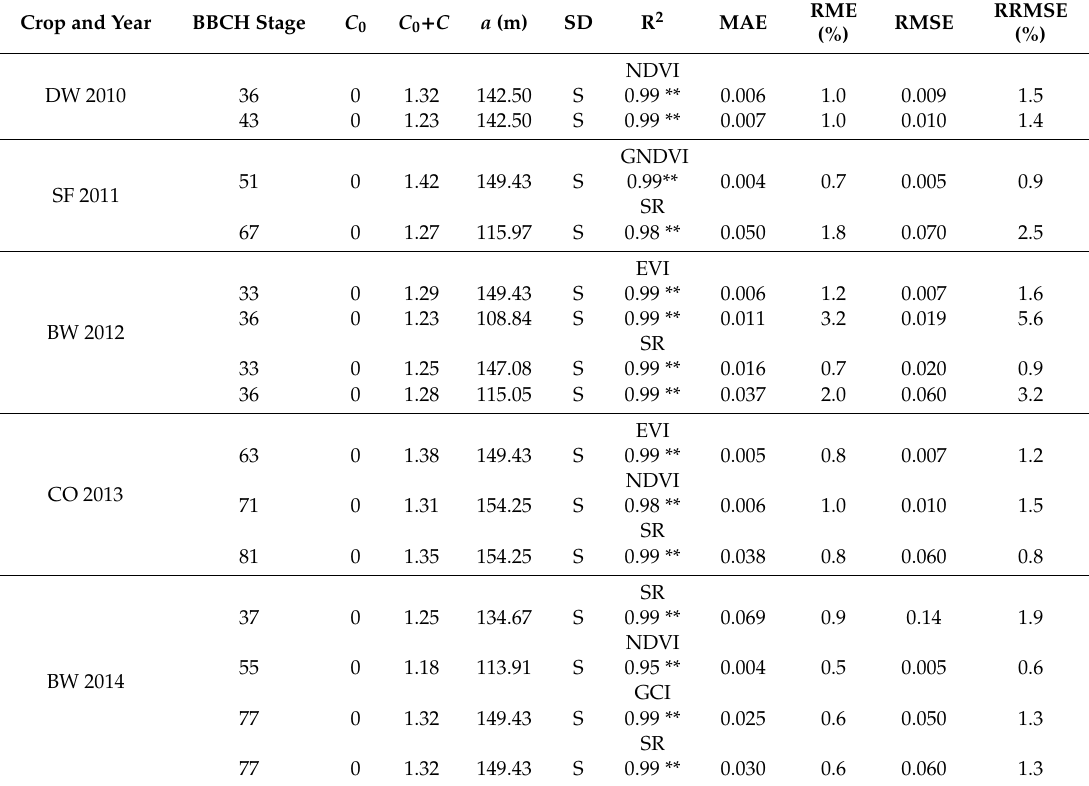
Table 7. Parameters of the spherical model used to fit the experimental semivariograms of remote vegetation indices and model performance in the five